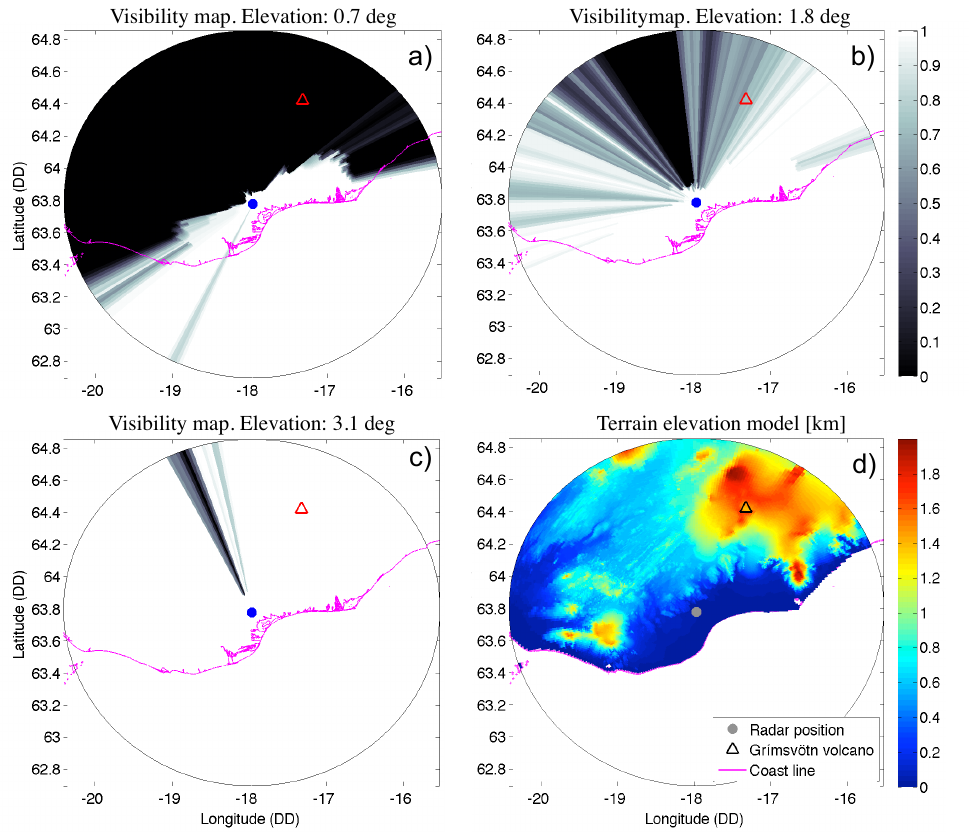
Fig. 2. Visibility maps at three elevations angles [deg]: 0.7 (a) , 1.8 (b) and 3.1 (c) for the Iceland DPX radar site. Dark and bright patches show areas where the radar signal is obstructed (visibility = 0) or free from obstacles (visibility = 1) caused by the orography. The terrain elevation model in kilometres, sampled into the polar coordinates radar reference system, is shown in (d) for comparison.